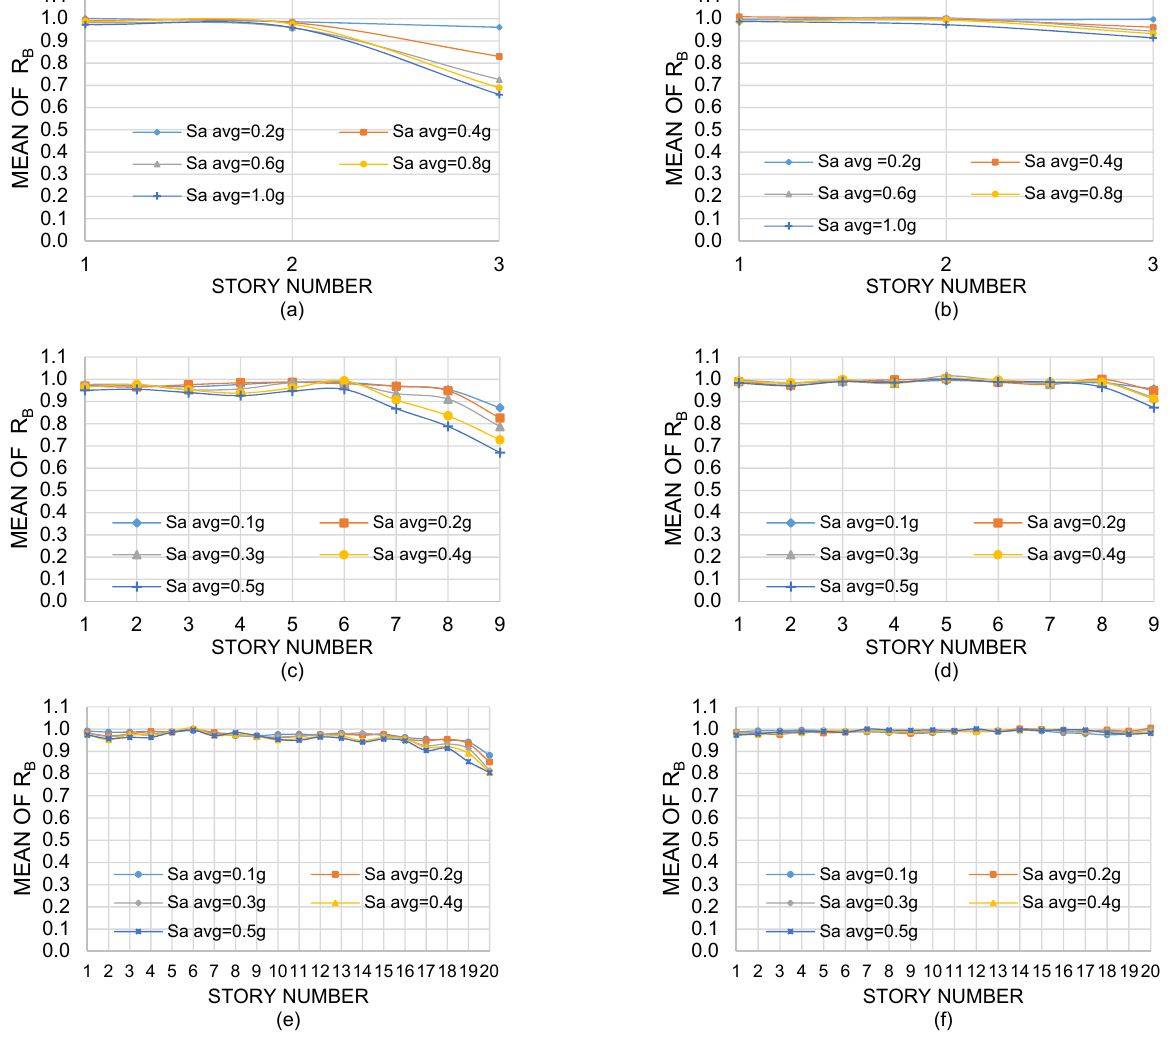
Figure 9. Mean values of R B , NS : ( a , c , e ), exterior columns of Models 1-2-3, respectively; ( b , d , f ), interior columns of Models 1-2-3, respectively.